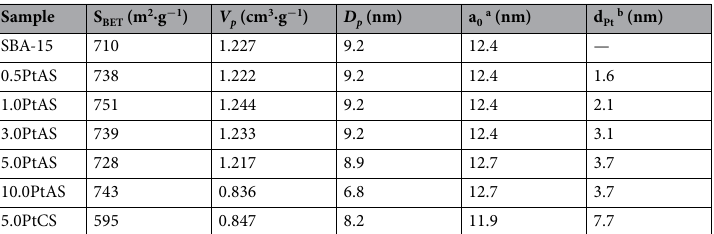
Table 1. Physicochemical properties of SBA-15, PtAS and PtCS samples. a Unit cell constant calculated according to a 0 = 2 × 3 − 1/2 × d 100 . b Pt crystallite size calculated by the Scherrer